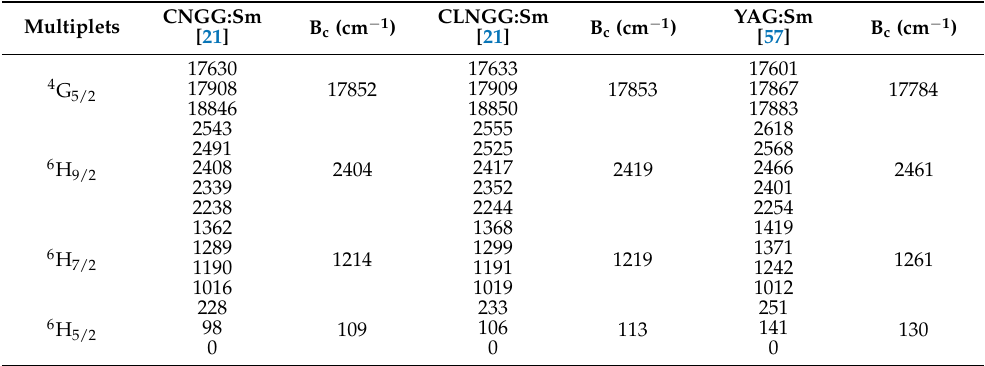
Table 5. Partial energy levels of Sm 3+ ions involved in the main emission lines in CNGG:Sm and CLNGG:Sm